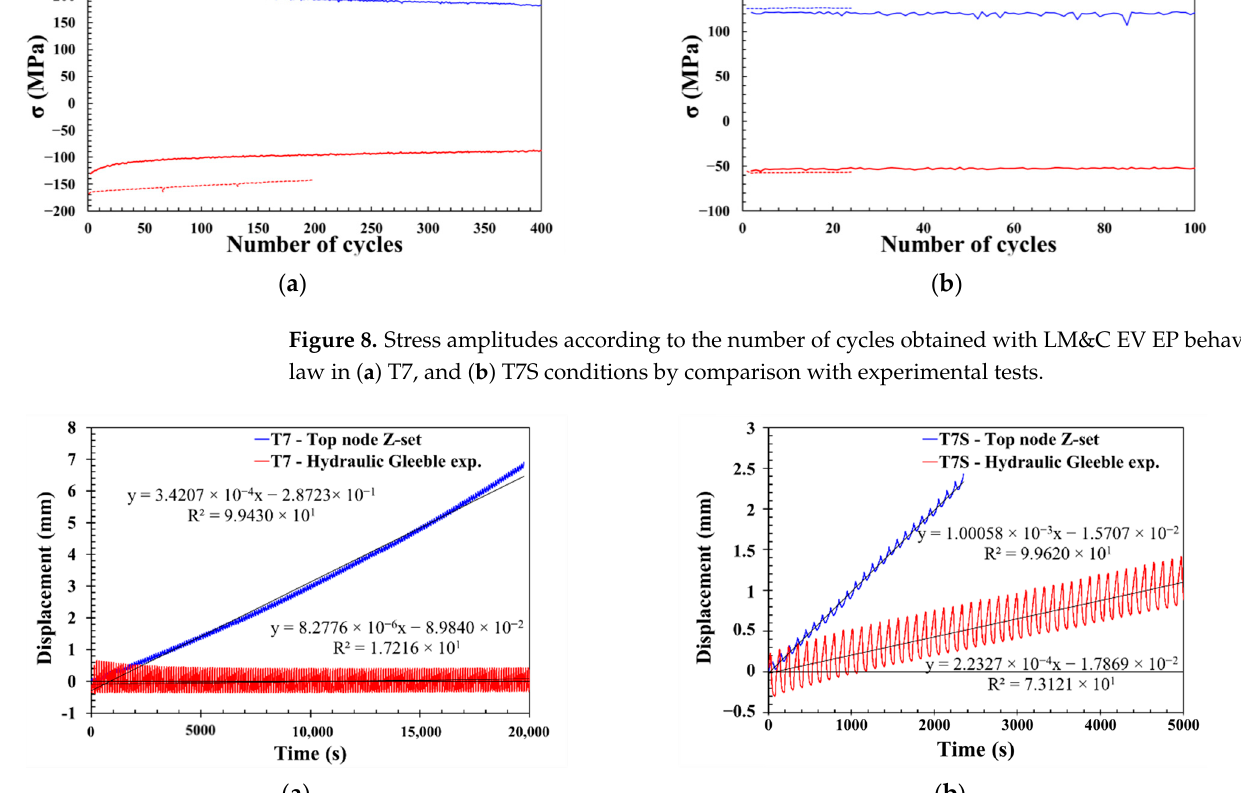
Figure 8. Stress amplitudes according to the number of cycles obtained with LM&C EV EP behav- ior law in ( a ) T7, and ( b ) T7S conditions by comparison with experimental tests.